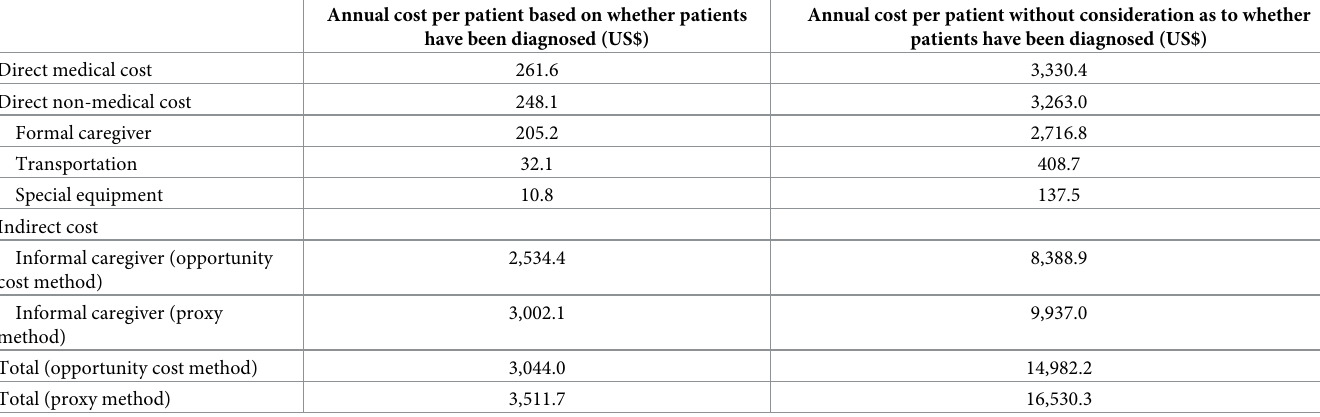
Table 3. Annual cost of dementia per person in 2010 in China. Annual cost per patient based on whether patients Annual cost per patient without consideration as to whether have been diagnosed (US$) patients have been diagnosed